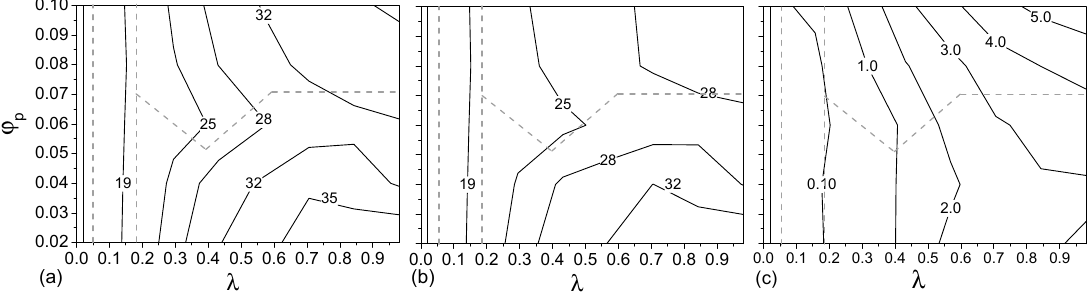
Figure 3. Relative ( a ) total free energy F total ; ( b ) total skin energy F skin ; and ( c ) core energy F core per terpolymer chain with respective to the ideal solution of aggregates formed at various ϕ p . The dashed line shows the phase boundary.